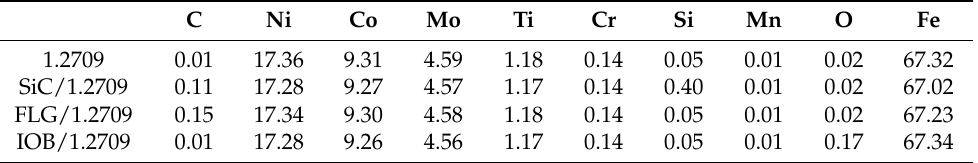
Table 5. Chemical composition of the uncoated and coated tool steel 1.2709 feedstock measured by optical emission spectroscopy and carrier hot gas extraction (for C and O) in